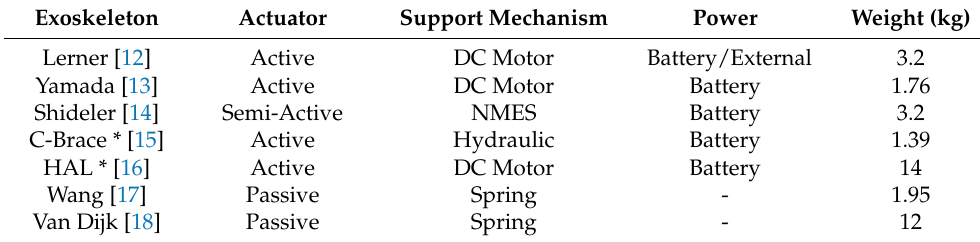
Table 1. Exoskeleton